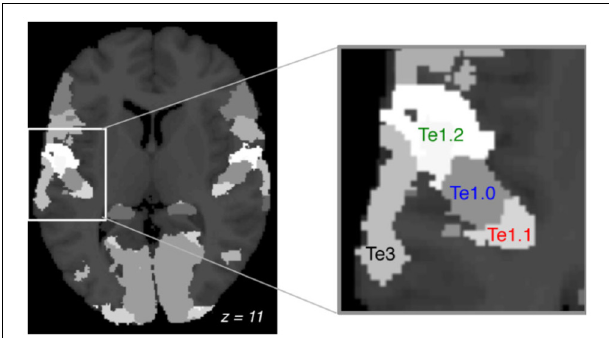
FIGURE 1 | Regions of interest. Cortical cytoarchitectonic areas defined by the anatomy toolbox (axial plane, MNI: z = + 11). Focus on the left auditory cortex and the four ROIs: Te1.1, Te1.0, Te1.2, Te3. Te1 is Heschl’s gyrus and Te3 is the planum temporale .